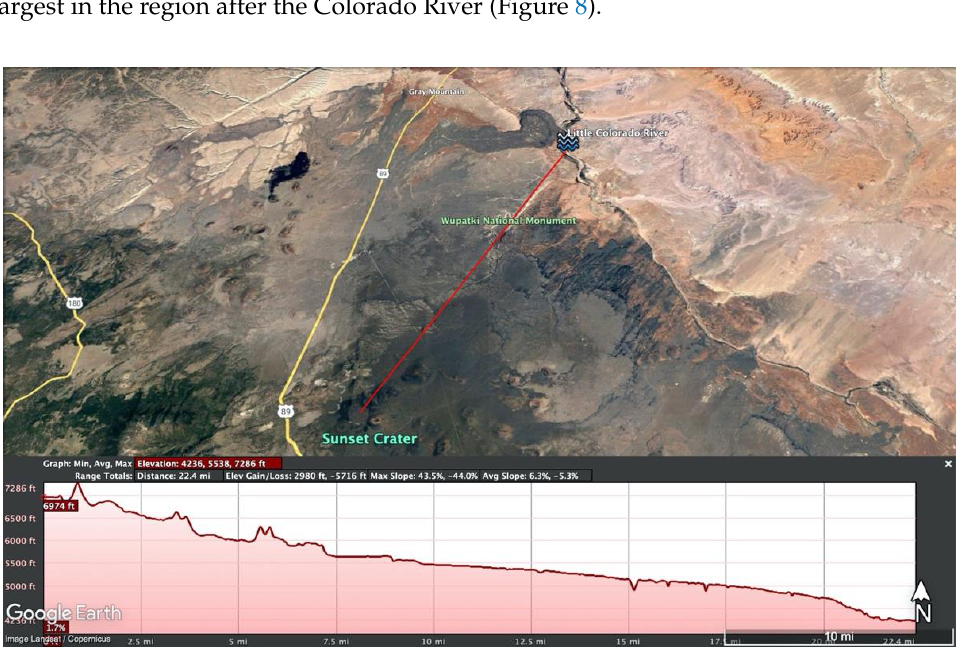
Figure 8. Elevation profile of Sunset Crater and Wupatki.